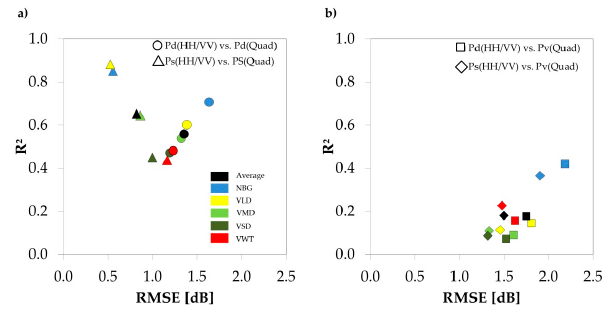
Figure 5. Averaged Squared Linear Pearson Correlation Coefficients (R 2 ) for none-water land cover classes (NBG, VLD, VMD, VSD, VWT) versus the Averaged Root Mean Square Errors (RMSE) of the linear models for C-Band features: ( a ) double bounce (P d ) and surface scattering (P s ) of the two and three component decomposition; ( b ) volume scattering (P v ). double bounce (P d ), and surface scattering (P s ) of the two component decomposition.